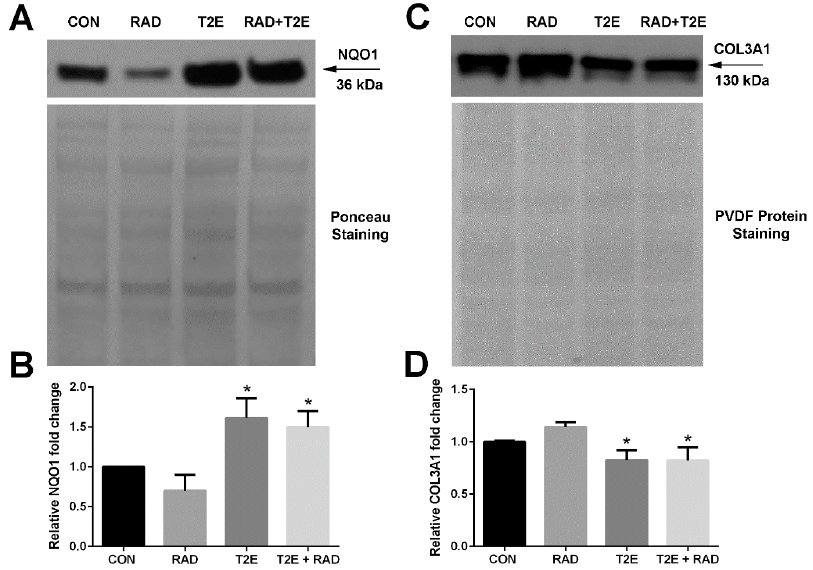
Figure 3. MnTE-2-PyP enhances NQO1 and reduces COL3A1 protein in human fibroblasts. ( A ). Western blot for NQO1 protein with Ponceau staining to control for protein loading. ( B ). Relative densitometry of NQO1 protein levels after normalization to Ponceau staining. ( C ). Western blot for COL3A1 protein with PVDF protein staining to control for protein loading. ( D ). Relative densitometry of COL3A1 protein levels after normalization to PVDF protein staining. Differences in protein expression were analyzed using a 1-way ANOVA followed by a post hoc Tukey’s test for multiple comparisons. The symbol (*) denotes a significant difference as compared to the control group. These data were obtained from 3 independent experiments.